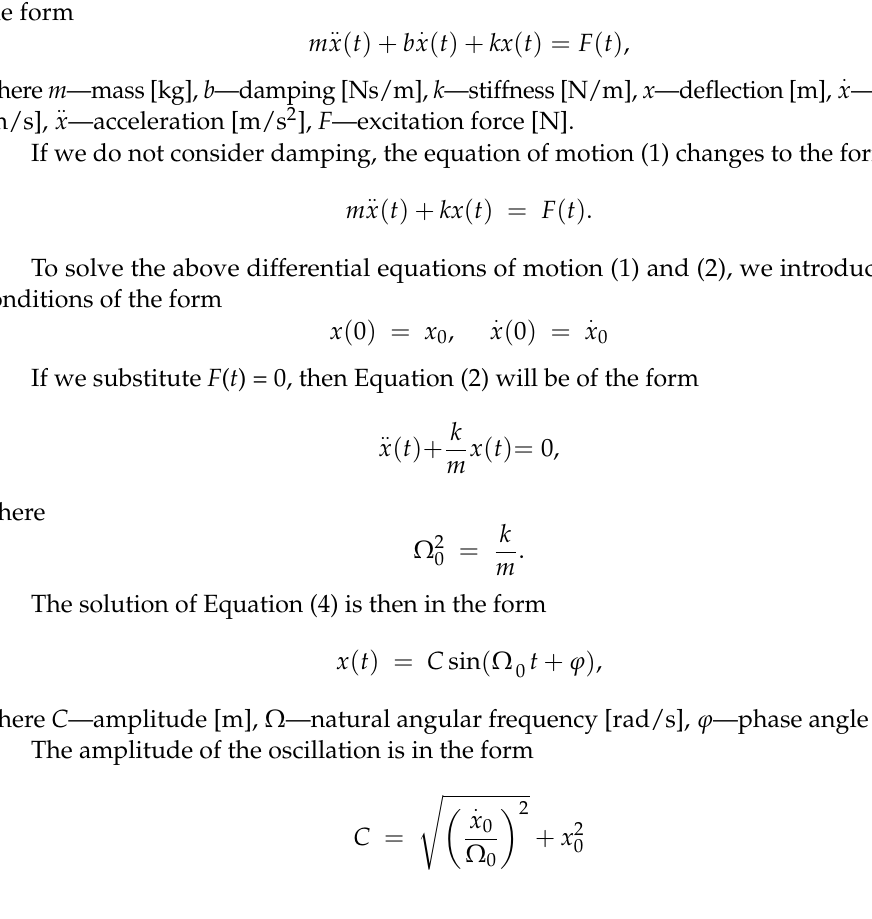
Figure 2. Scheme of the system with one degree of freedom (Legend: m —mass, b —damping, k —stiffness, x ( t )—deflection, F ( t )—excitation force). The equation of motion of a system with one degree of freedom can be written